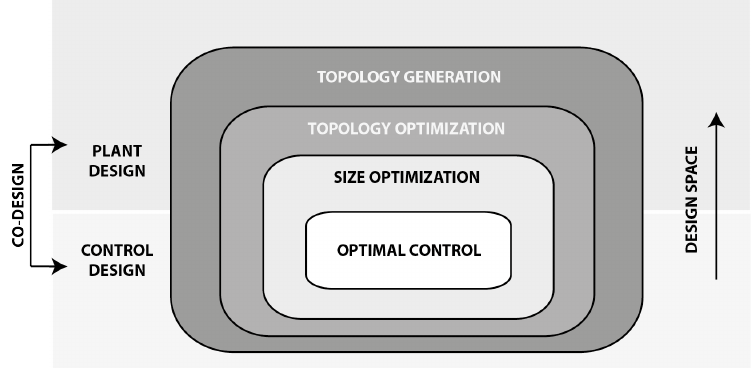
Figure 15. Optimization levels of an